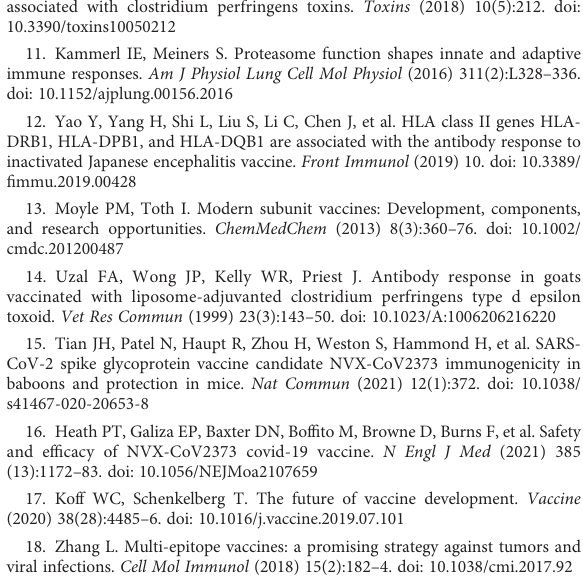
SUPPLEMENTARY FIGURE 5 SASA values per epitope. Values over the last 500 ns of convergent simulation are shown for epitopes “ 0 ” to “ 10 ” (excluding “ 4 ” ) in panels A to I , respectively. The SASA of all epitopes shown but “ 5 ” and “ 9 ” achieved convergence. Epitope “ 8 ” only achieved convergence during the last 400 ns (enclosed in a red box, close-up in inset plot). So, only this region was considered for its mean SASA computations. SUPPLEMENTARY FIGURE 6 Comparison of all plausible clusters of docking of MEP_12 against TLR1/ TLR2andTLR4/MD-2.ThebestbindingmodesofclustershavingHaddock- scores with overlapping error bars (standard deviations) are shown for the dockings (A) MEP_12-TLR1/TLR2, and (C) MEP_12-TLR4/MD2. TLR1 and TLR2chainsarecoloredingreenandorange,respectively.Attachedglycans are shown as sticks in cyan. In (A) , the best binding modes of MEP_12 from clusters “ 1 ” , “ 2 ” , “ 3 ” , and “ 4 ” are colored in red, cyan, gray, and blue, respectively. In (C) , the best binding modes of MEP_12 from clusters “ 1 ” , “ 3 ” , “ 5 ” , and “ 6 ” are colored in gray, blue, red, and cyan, respectively. (B) Enlarged view of the best binding mode of cluster “ 1 ” (red cartoon with transparent surface) in the docking MEP_12-TLR1/TLR2. The N-terminal residues missing in TLR1/TLR2 structure (in gray) were completed by structural alignment to a TLR2 model from the AlphaFold Protein 1300 Database. These interact with MEP_12 cluster “ 1 ” . (D) Best binding modes from cluster “ 3 ” and “ 6 ” from the docking MEP_12-TLR4/MD2. The black lineseparatingthetwosidesofTLR4/MD-2representsasymmetryaxis.The binding modes of left side become equivalent to the right side after a 180° right-handed rotation, as shown in (E)